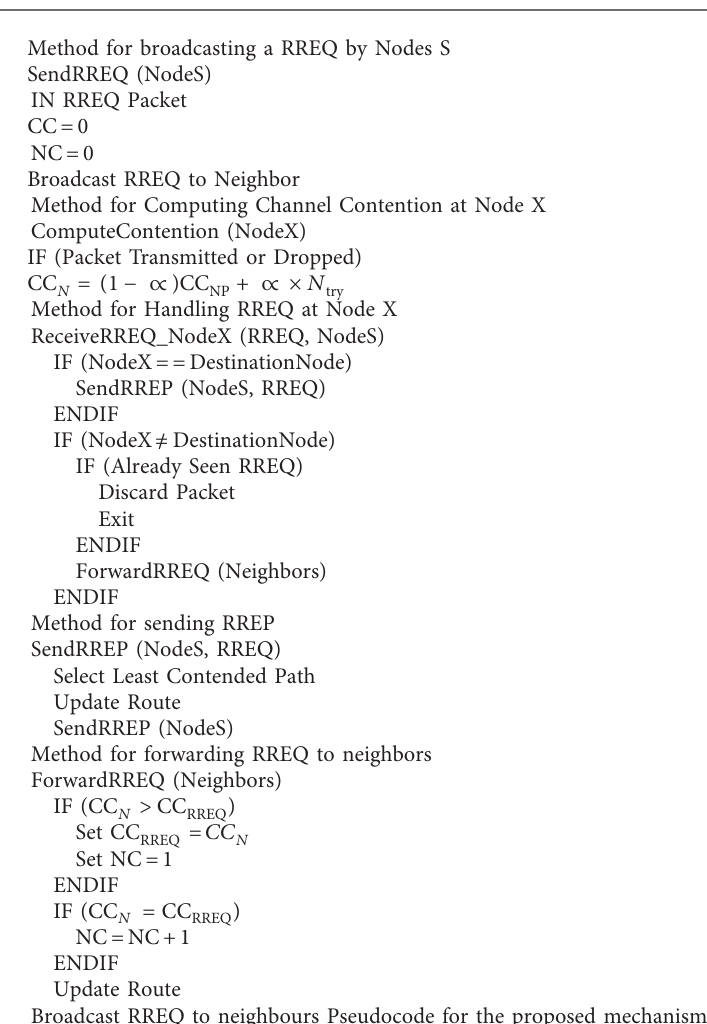
Table 1. The best value chosen for α is 0.55 and it is selected on the basis of packet delivery ratio. The packet delivery ratio achieved with each value of α is depicted in Figure